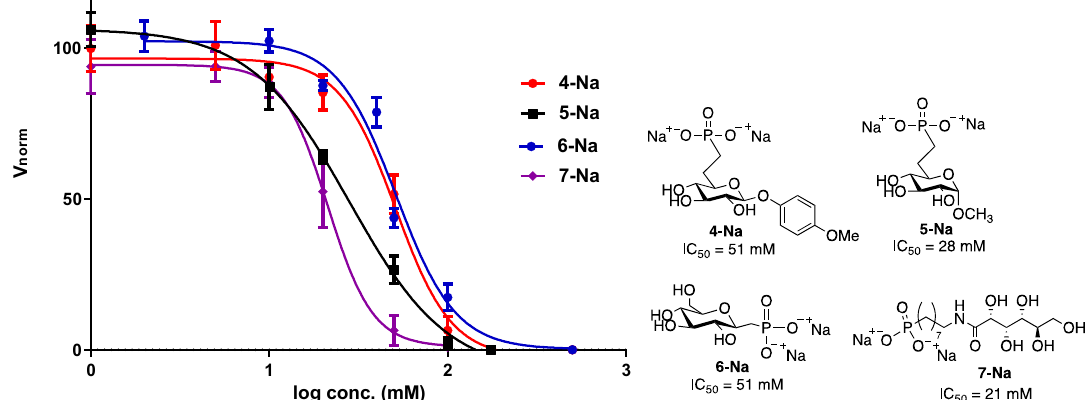
Figure 3. Structures and IRI activity of sodium phosphonate compounds 4–7 . IRI activity is defined by dose response curves of the rate of ice recrystallization inhibition as a function of log concentration. Rates were measured in triplicate and were normalized against a phosphate-buffered saline (PBS) control. A non-linear regression curve was fitted to points to generate IC 50 values. Error bars represent % SD for n = 3 experiments.